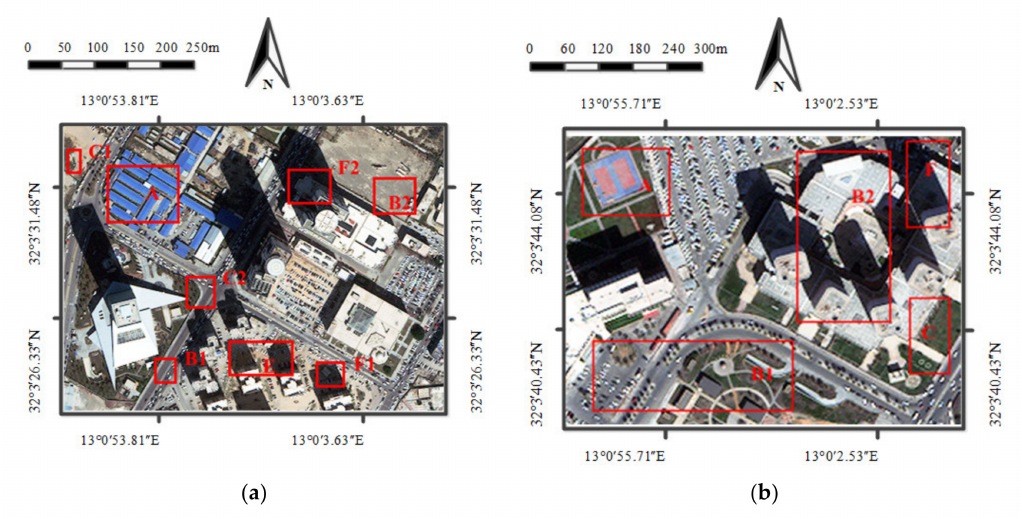
Figure 4. Test images from WorldView-3 images of Tripoli, Libya. ( a ) Tripoli-1. ( b )